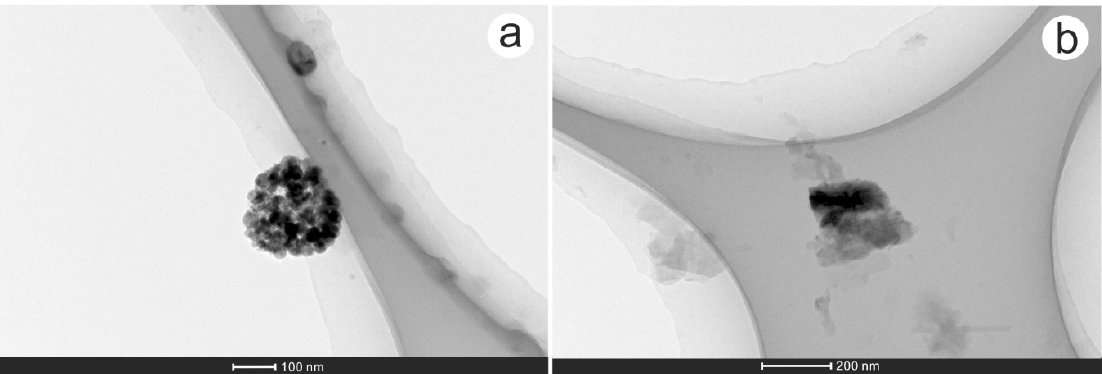
Figure 8. TEM images of Au-bearing nanoparticles in fault gouges; ( a ) Au-bearing particle aggregation; ( b ) a Au-bearing particle.